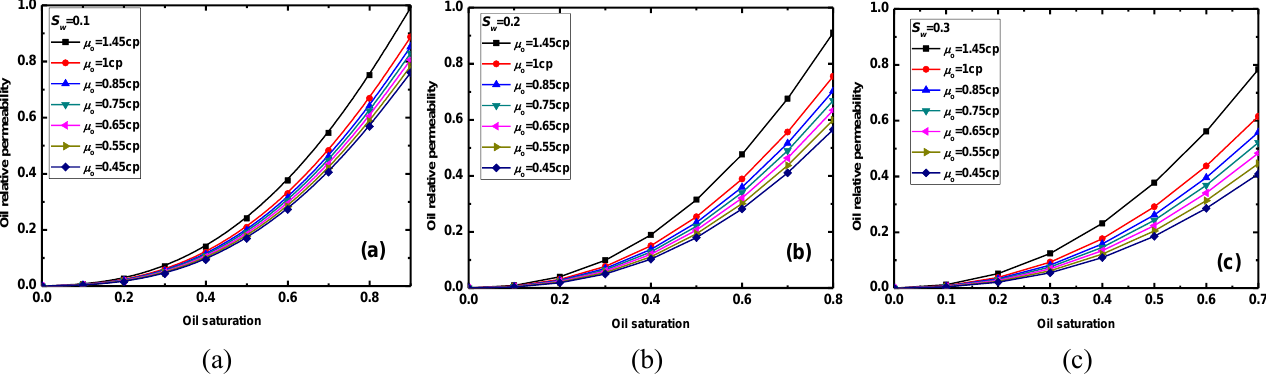
Figure 5—Oil relative permeabilities for fracture systems. The curves represent three-phase data at various oil viscosities with different water saturations. (a) The value of water saturation is 0.1. (b) The value of water saturation is 0.2. (c) The value of water saturation is